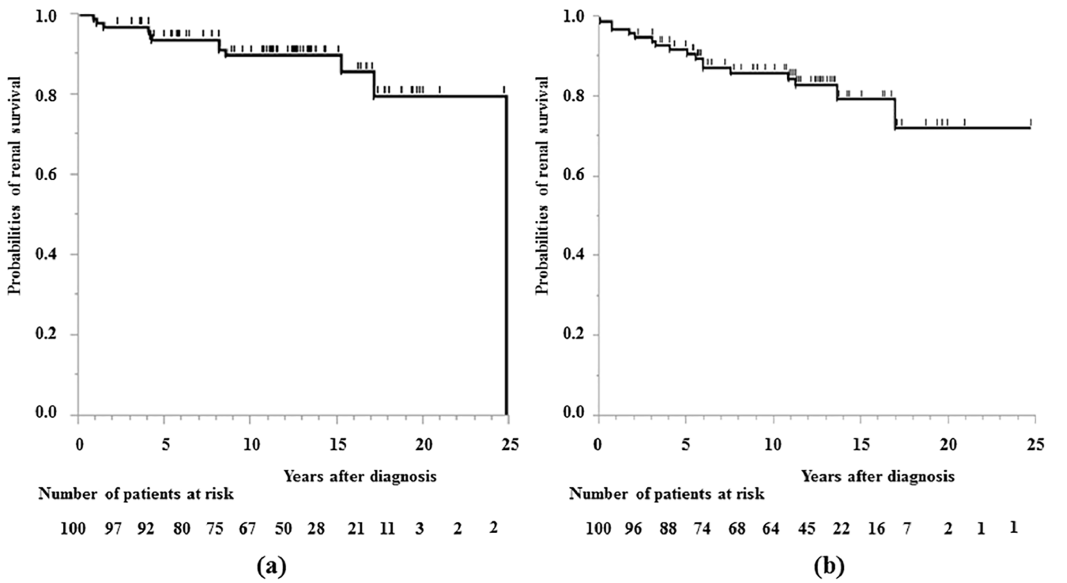
Fig 1. Renal survival curve of all patients. a) Kaplan-Meier plot showing time to ESKD. b) Kaplan-Meier plot showing time to CR.